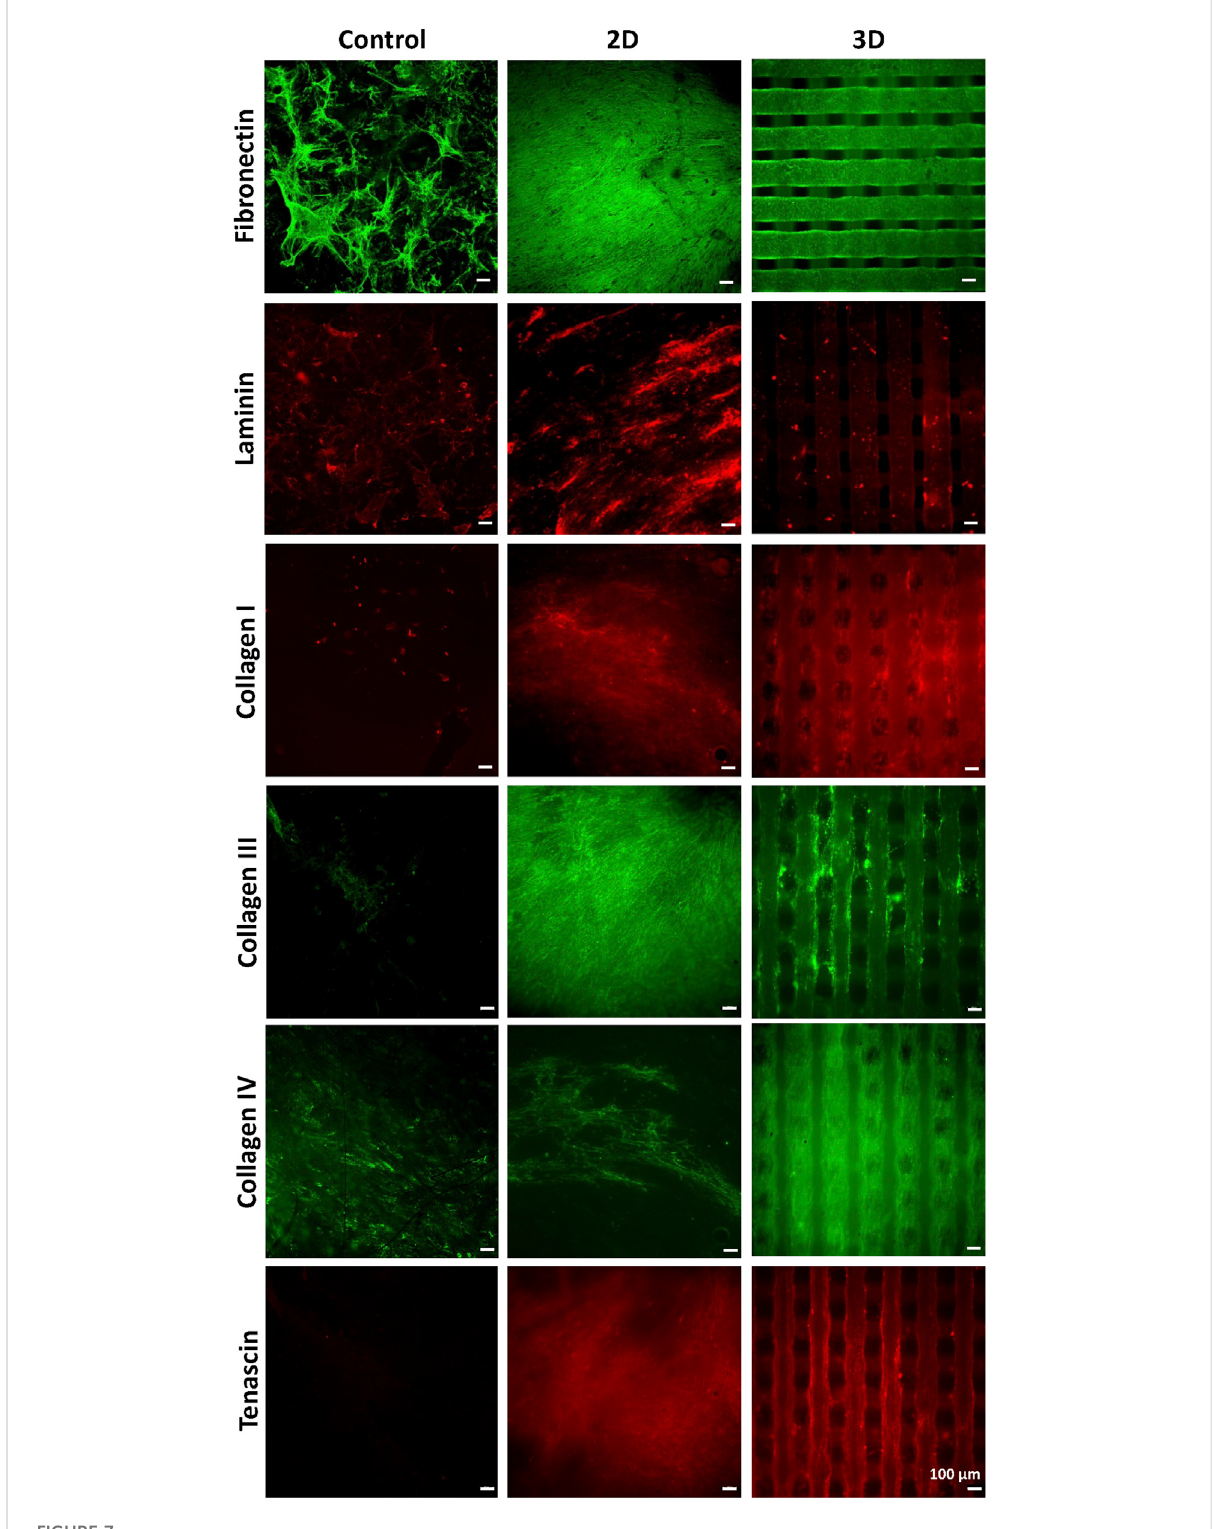
FIGURE 7 Immunostaining for Collagen -I, -III, -IV, for Fibronectin, Laminin, and Tenascin performed after decellularization, on PCL/polyDOPA/G scaffolds and control samples cultured for 3 weeks with